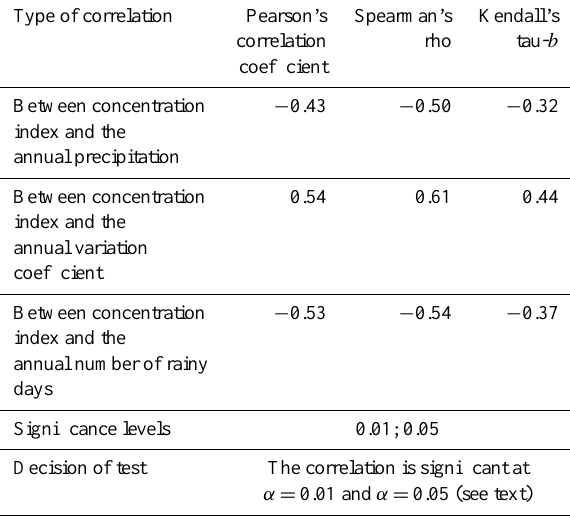
Table 4. Values of Pearson’s correlation coefficient, Spearman’s rho and Kendall’s tau- b for three pairs of variables: (CI, P ), (CI, CV) and (CI, N